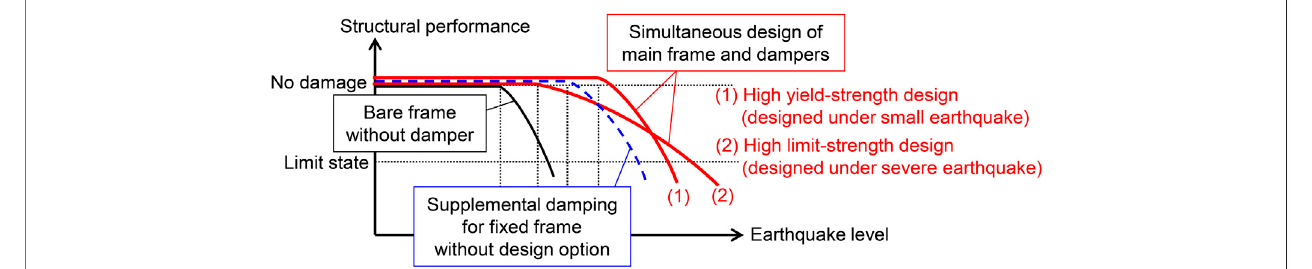
Frontiers in Built Environment |